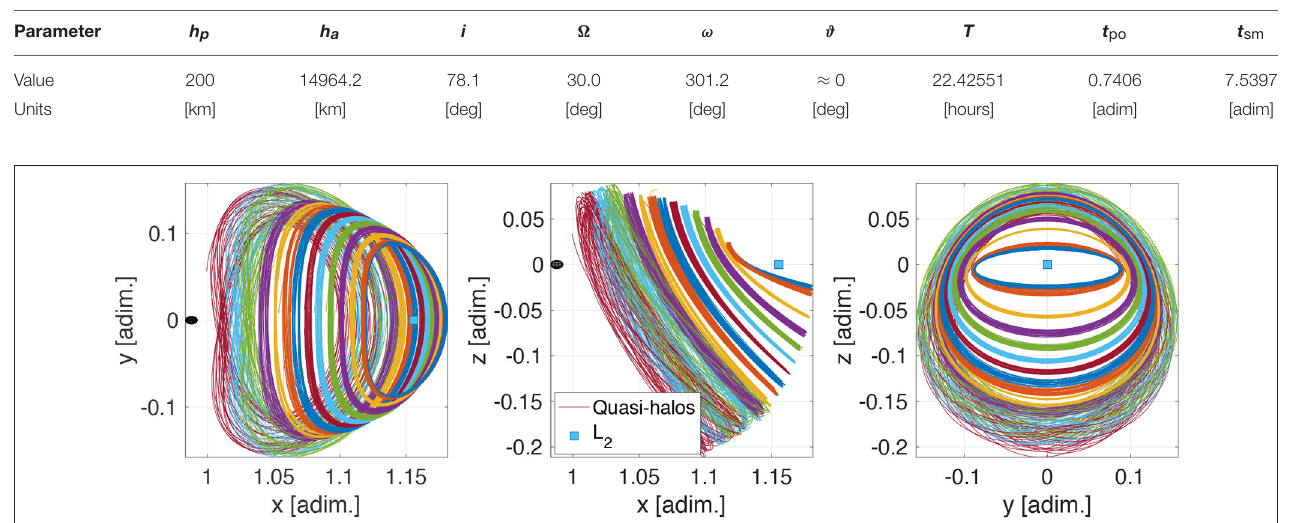
TABLE 8 | Main parameters for the transfer phase.